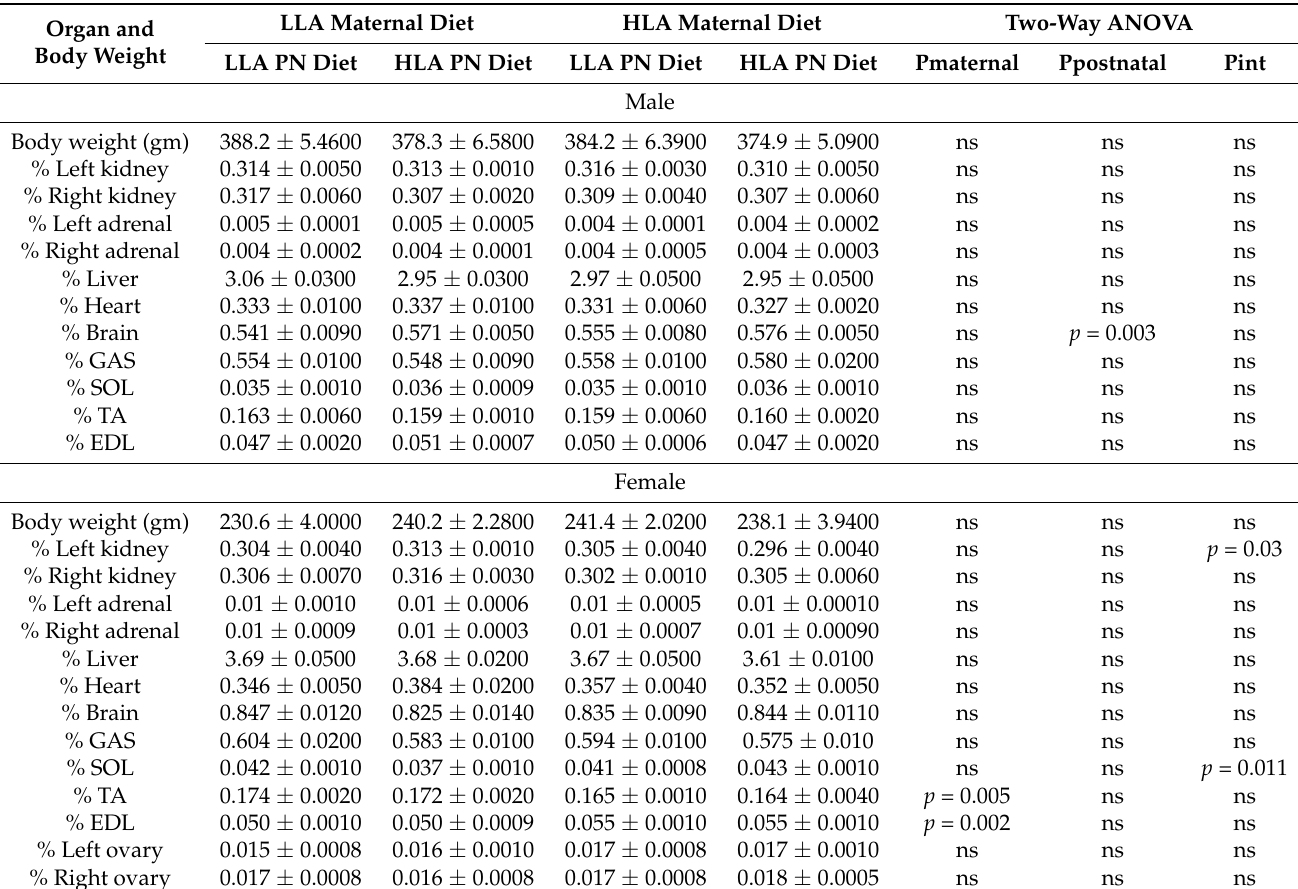
Table 1. Effect of a maternal and postnatal diet high in linoleic acid on body weight and organ weight of adult offspring. Organ and Body